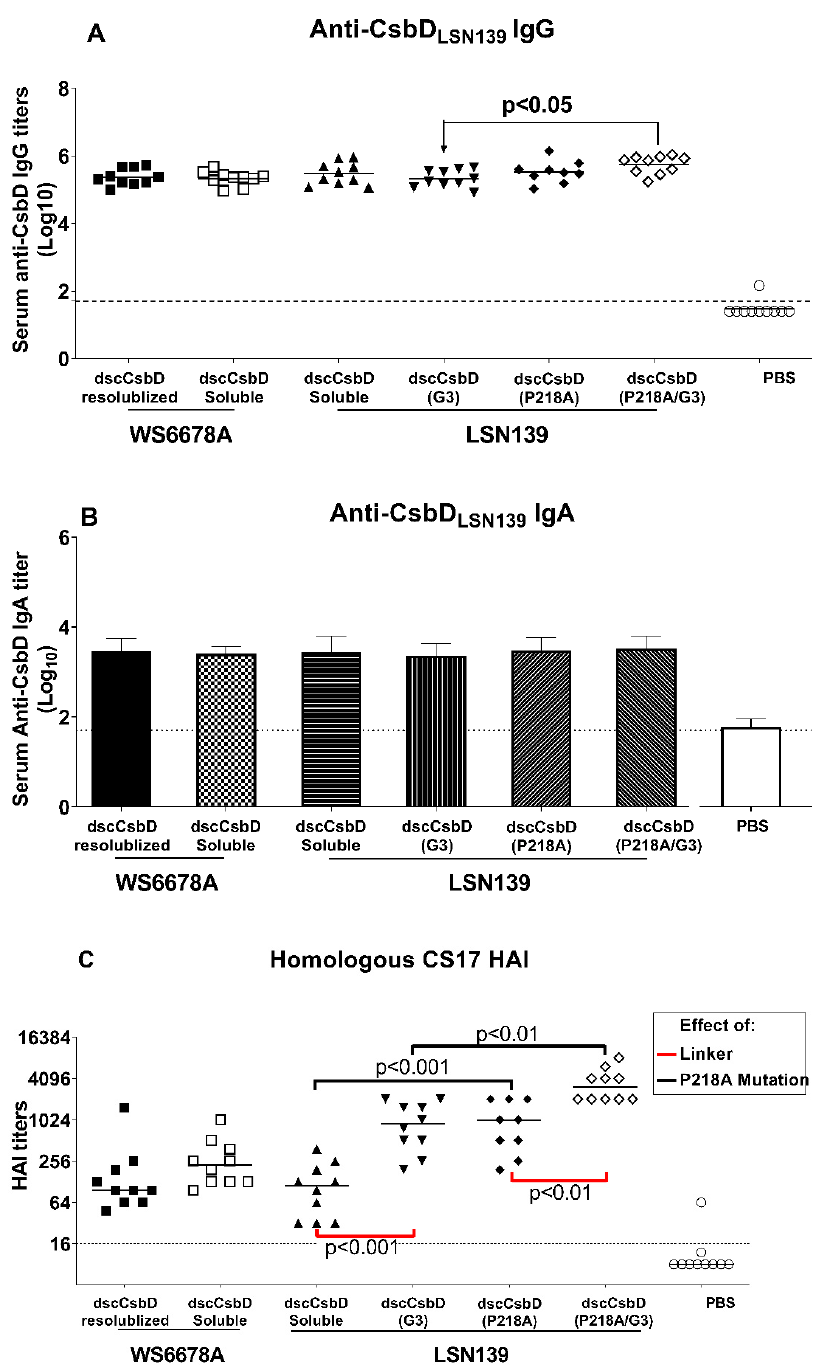
Figure 2. Serum antibody responses in mice immunized IN with CsbD-based antigens. Mice (9–10/group) were immunized on days 0, 14, and 28 with 25 µ g of antigen and with 1.5 µ g LT(R192G). ( A ) Serum anti-dscCsbD LSN139 IgG antibody responses on day 42. ( B ) Serum anti-dscCsbD LSN139 IgA antibody responses on day 42. ( A , B ) All values shown are the individual log 10 titers in serum collected two weeks after the third dose (day 42). Solid horizontal lines represent the mean of each group, and the horizontal dotted lines denote the lowest dilution tested (1:50). ( C ) Functional antibody titers measured by the HAI assay using CS17 + ETEC strain LSN139. Individual values are shown with the medians of each group represented by a horizontal solid line. Horizontal dotted lines denote the lowest dilution tested for the assays (1:16). Statistical significance was determined by using a one-way ANOVA and Tukey’s post hoc